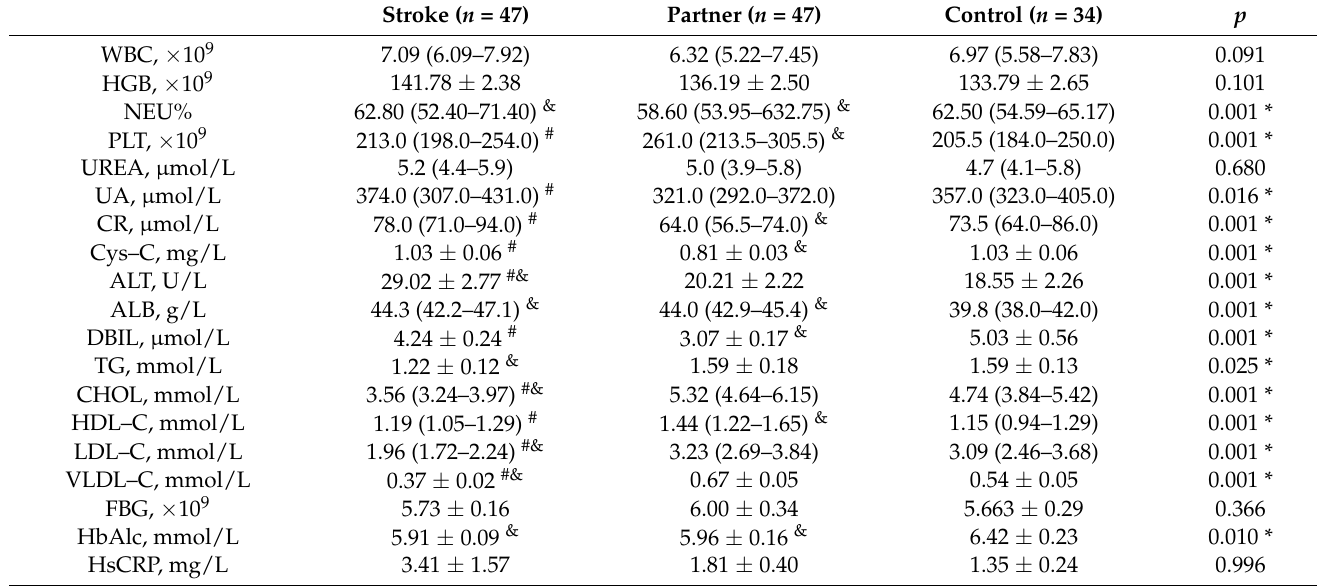
Table 2. Clinical test results of the